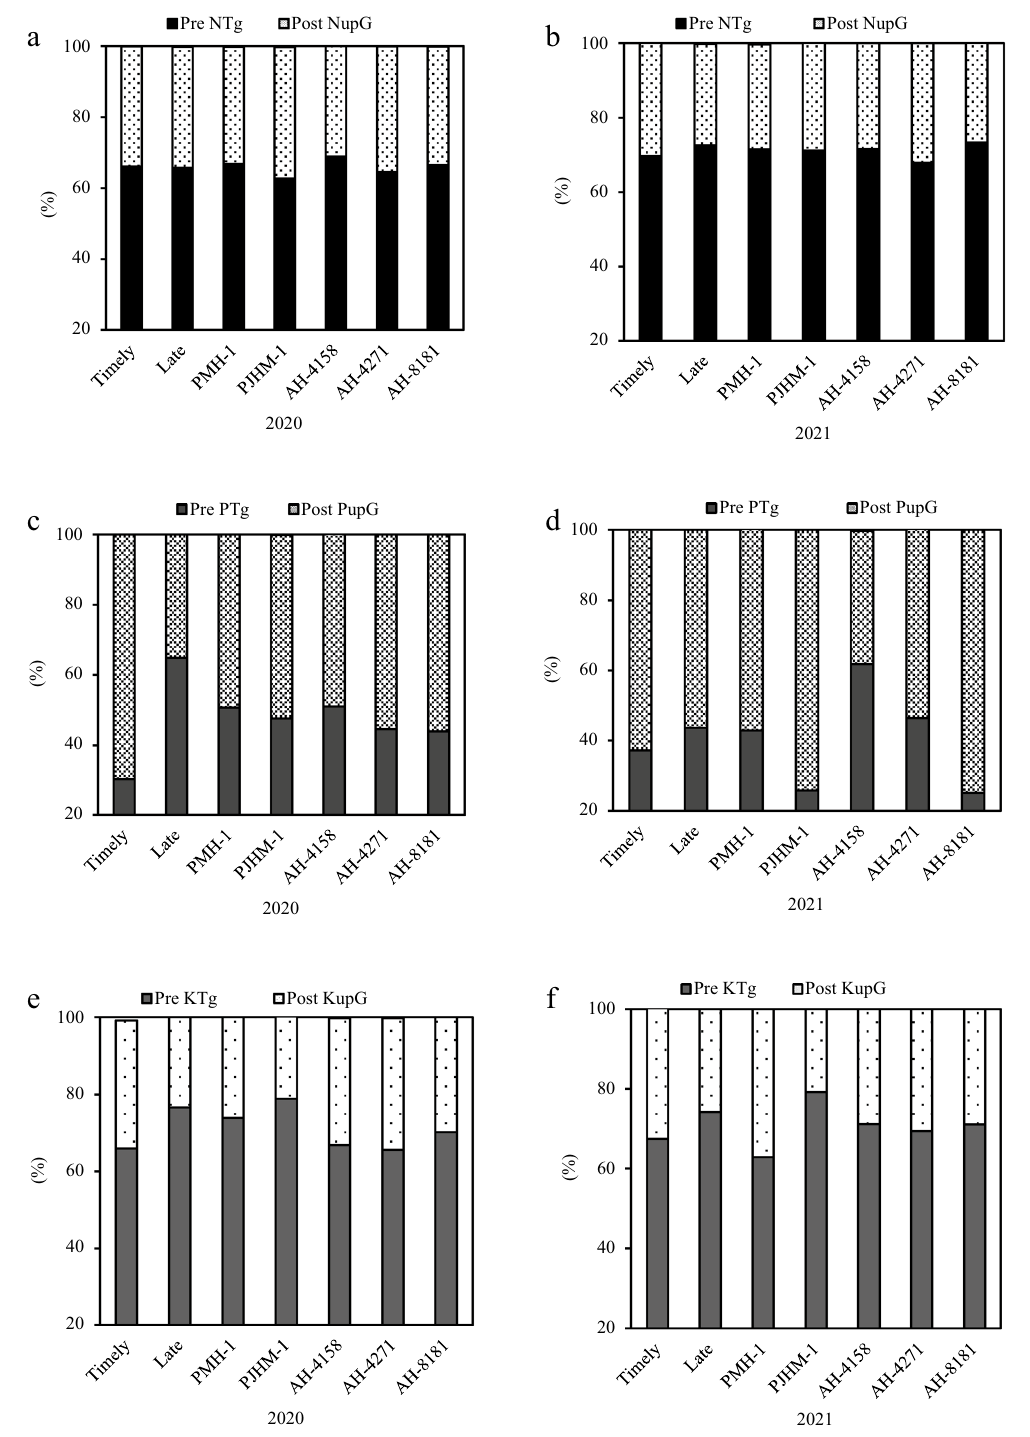
Figure 5. Pre NTg- Pre-anthesis nitrogen translocation and Post NupG- Post-anthesis nitrogen uptake contribution to grain yield ( a , b ); Pre PTg- Pre-anthesis phosphorus translocation and Post PupG- Post-anthesis phosphorus uptake contribution to grain yield ( c , d ); Pre KTg- Pre-anthesis potassium translocation and Post KupG- Post-anthesis potassium uptake contribution to grain yield ( e , f